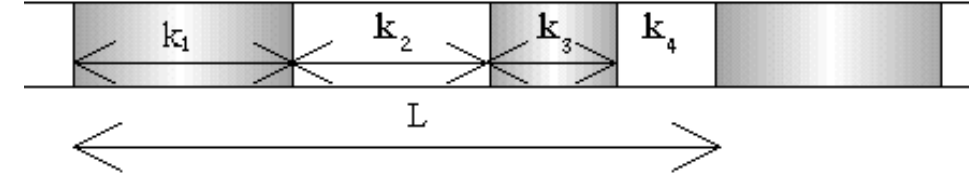
Figure 2. Polydisperse chain of inclusions.